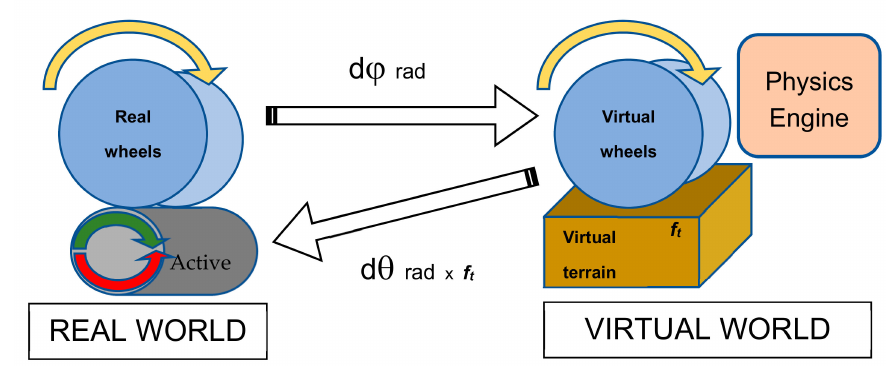
Figure 11. Schema of bidirectional transmission of the angle of rotation of real and virtual wheels.